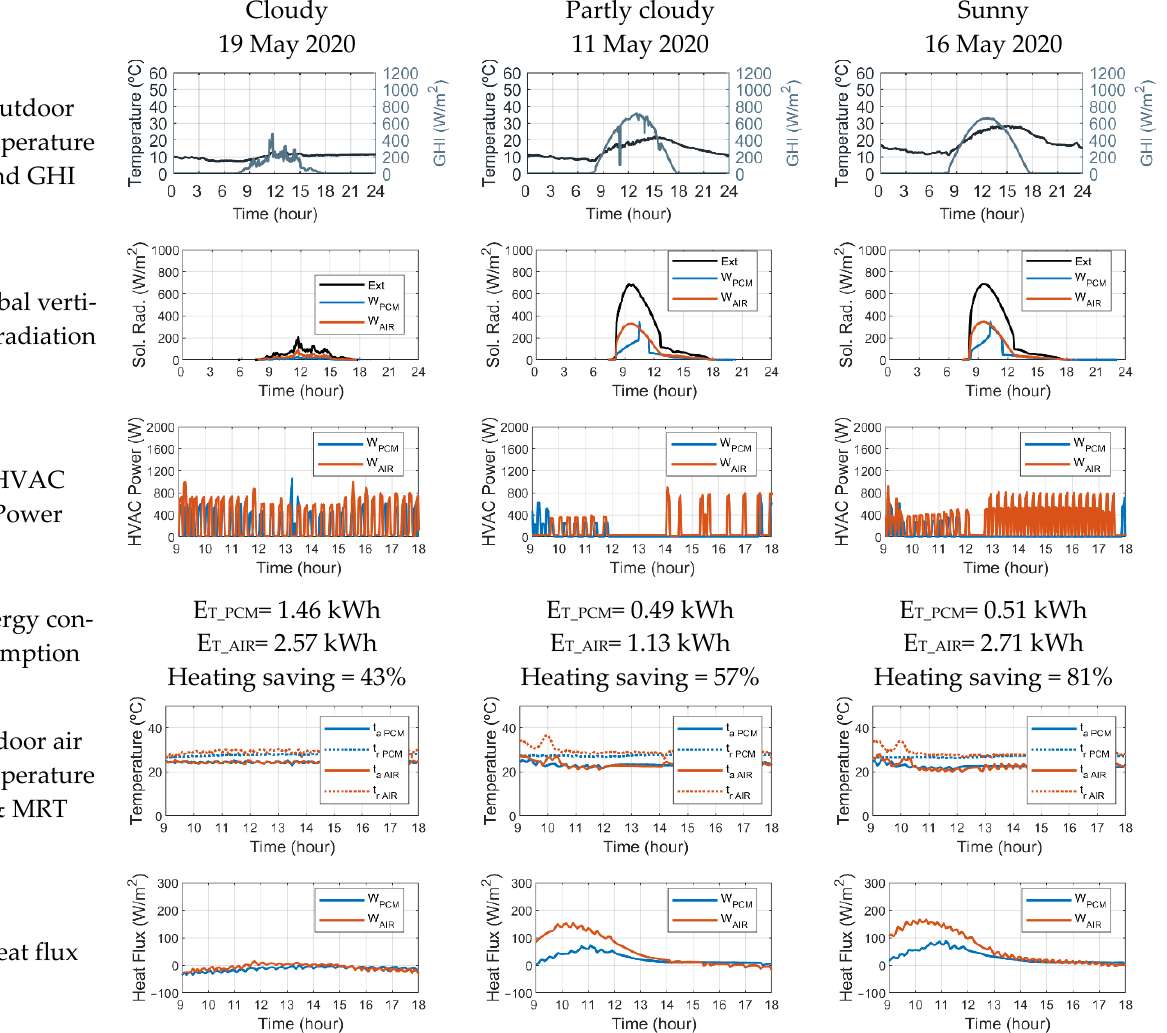
Figure 10. Results for representative days of mid-season warm. ( a ) Outdoor temperature and global horizontal radiation (GHI); ( b ) global vertical radiation; ( c ) HVAC power and energy consumption; ( d ) indoor air temperature & mean radiant temperature (MRT); ( e ) heat flux; ( f ) PMV; ( g ) PMV*; ( h ) DGP. Cloudy Partly cloudy Sunny